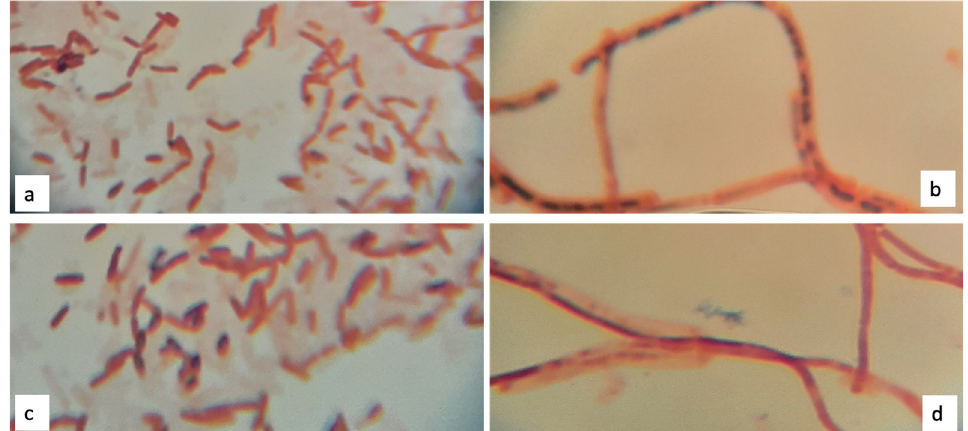
Figure 2. Schaeffer-Fulton endospore staining with Malachite green ( a , b ) and Methylene blue ( c , d ); presence of green and blue granules, respectively, for the strain 1B ( a , c ) and 2D1 ( b , d ).